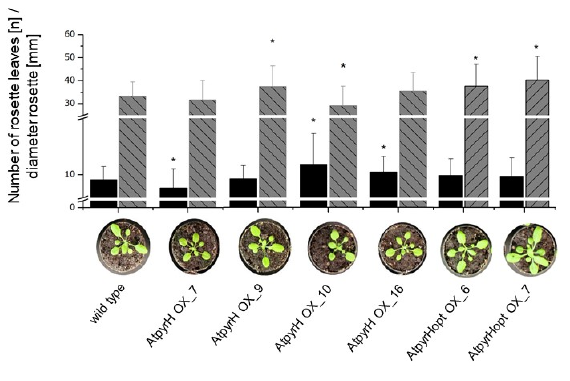
− + + − AtprnAopt 1 + + − 1 for plants optimized gene version. Table 2. Analysis of chlorinated compounds in different transgenic Arabidopsis thaliana lines. The values (µg/g dry weight) are approximates, as reproducible results were not obtained in all samples, and given as a range of lowest to highest detected value over all lines where the compound was detected. In samples indicated with (+) a peak was identified but that was below the limit for quantification. ( − ) indicates below detection